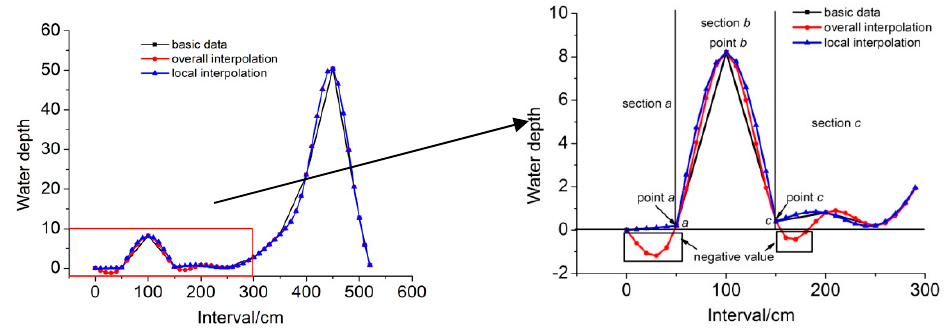
Figure 4. Comparison between overall and local cubic spline interpolation: direct view ( left ) and expanded view ( right ).